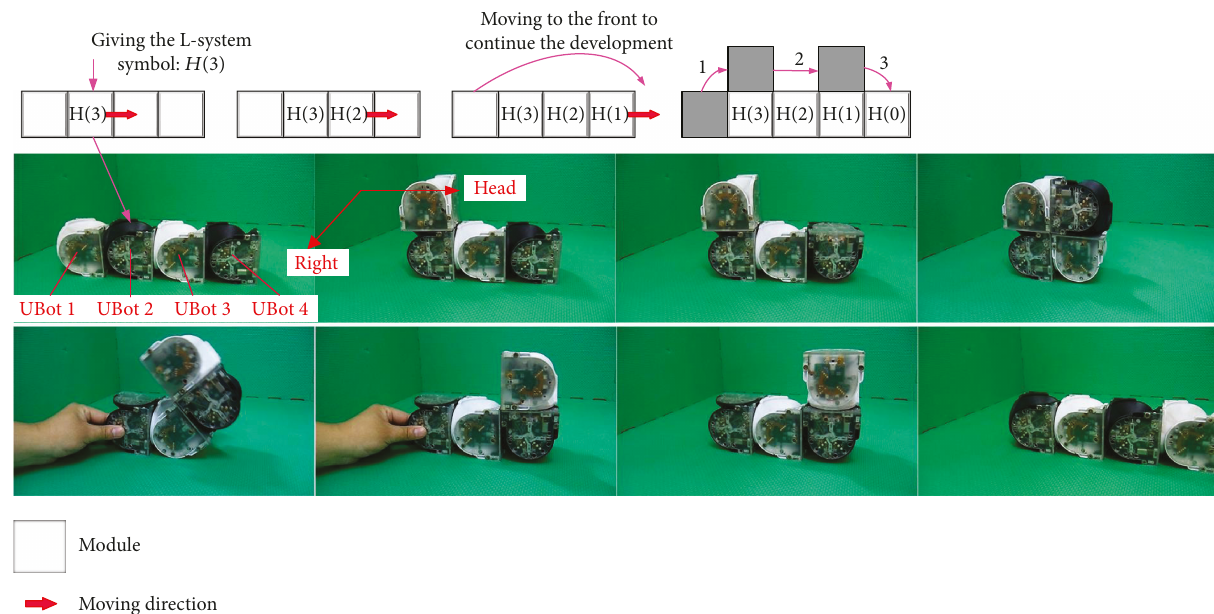
Figure 15: The hardware experiment for interpreting symbols H 3